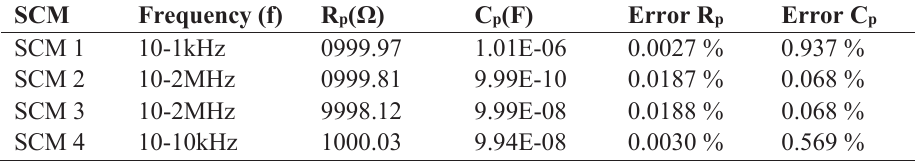
Table 1: Impedance parameters and errors calculated by LEBISDI for the capacitive circuit models (CCM) studied. SCM